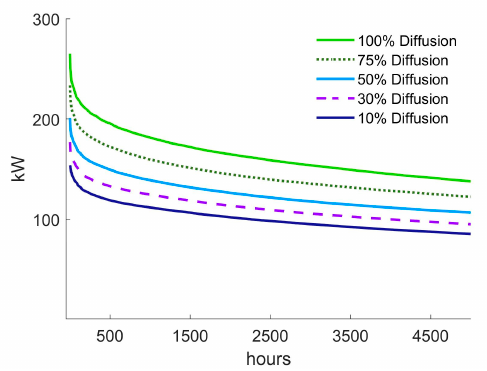
Figure 6. Duration curve with uncontrolled charging (UC).